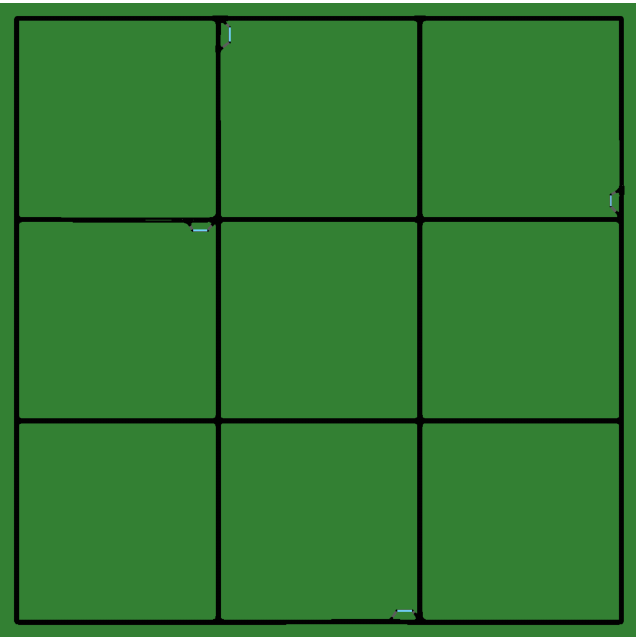
Figure 4. Example of the 3 × 3 grid road network within